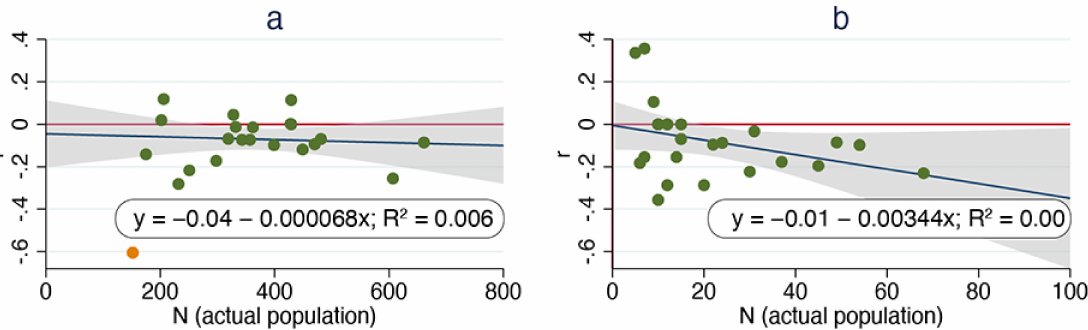
Figure 5. Calculated per capita growth rate vs. free-roaming cat population, ORCAT program 1995–2016 ( a ) and UCF program 1995–2018 ( b ). Dark blue lines are best-fit lines derived from linear regression. Outlier (as determined via residual analysis) for ORCAT data is shown in orange and excluded from linear best-fit.